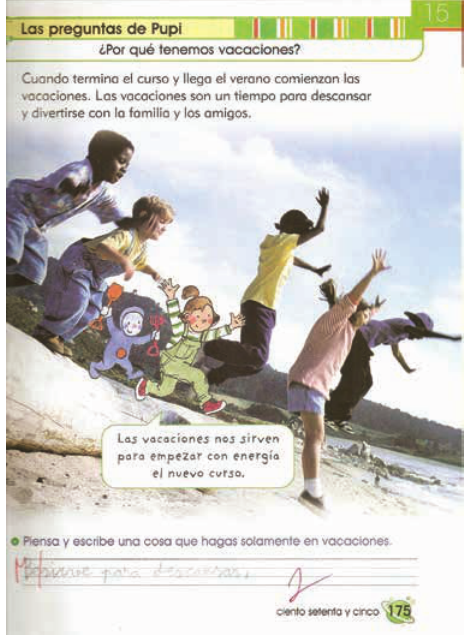
Figure 2: Global Method Stage One of Primary School, year 2009. Source: Ferrándiz et al . (2009: